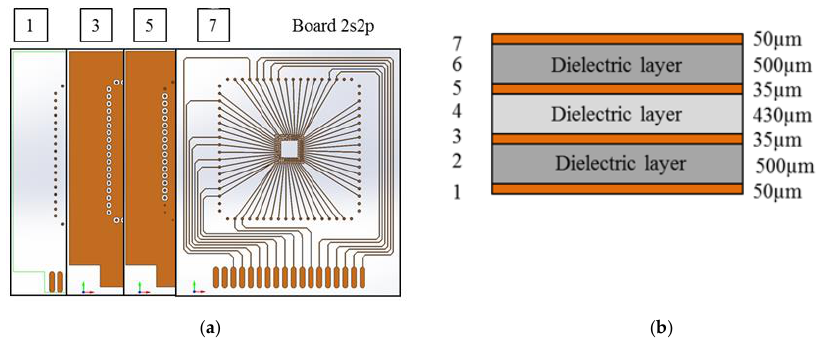
Figure 3. JEDEC 2s2p thermal test boards: Copper traces definition ( a ) and stack-up ( b ).